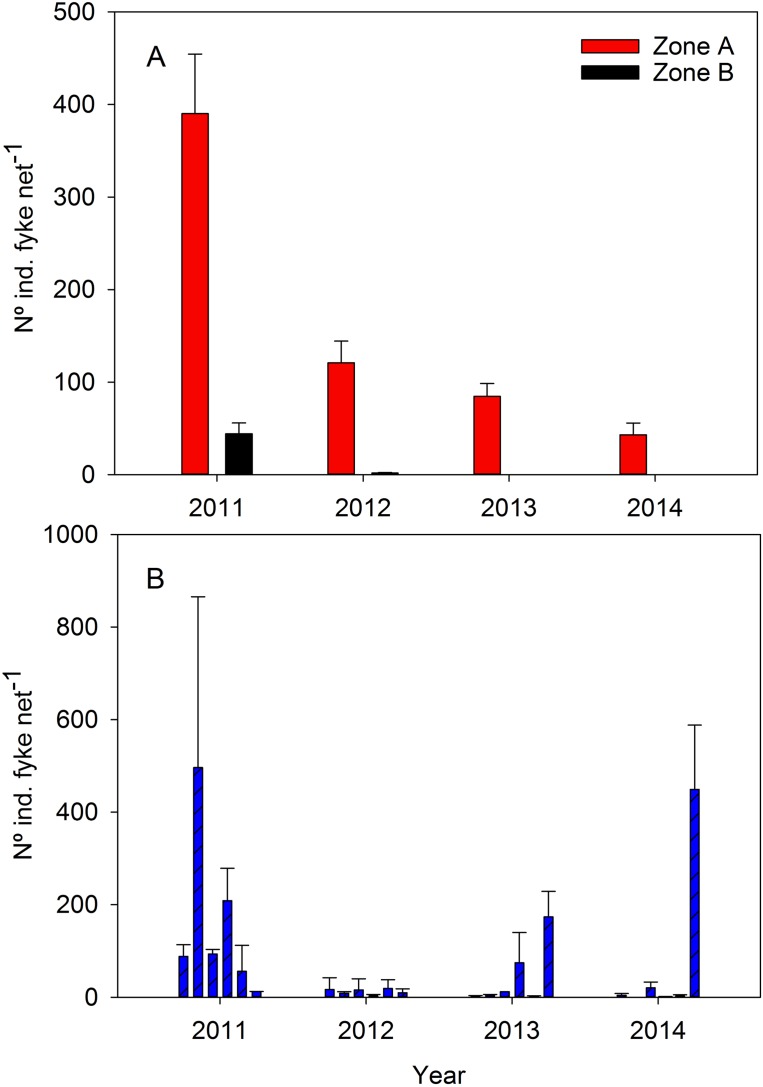
Number of A. iberus individuals captured within fyke nets.(A) The two study zones. (B) The six isolated ponds located within the zone A. Error bars are the standard error.